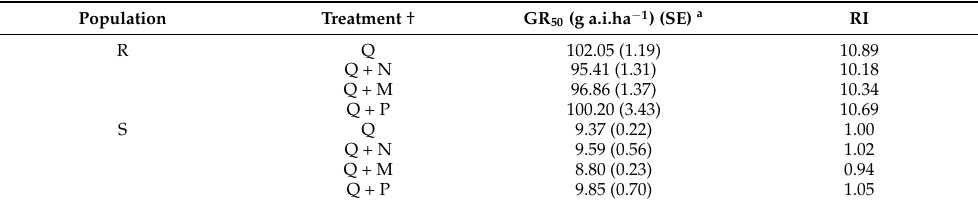
Table 1. Effects of cytochrome P450 inhibitors (malathion and PBO) and GST inhibitor (NBD-Cl) on Polypogon fugax growth response to quizalofop-p-ethyl.